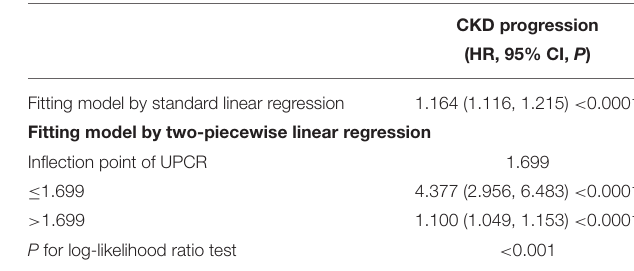
TABLE 5 | The result of the two-piecewise linear regression model.